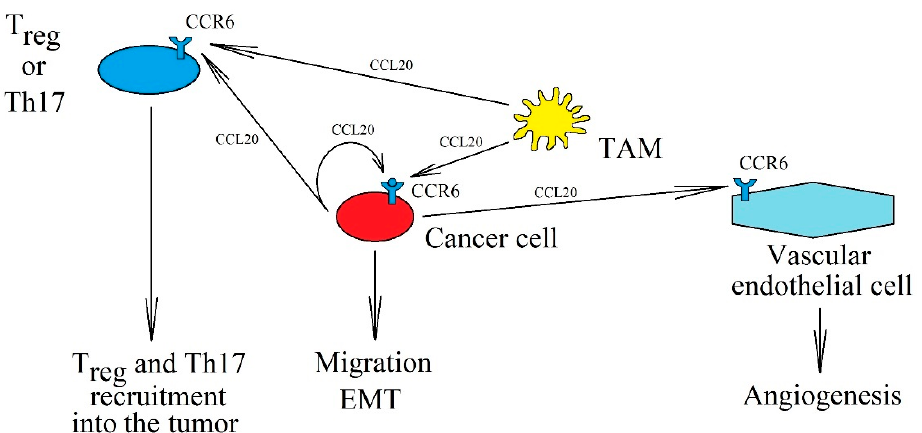
Figure 3. The significance of the CCL20 → CCR6 axis in cancer processes. CCL20 is expressed in tumor cells and TAM, which can activate CCR6 on cancer cells in an autocrine manner, causing their migration and EMT. In addition, increased concentration of CCL20 in the cancer microenvironment recruits T reg and Th17 into the tumor niche and causes angiogenesis via CCR6.